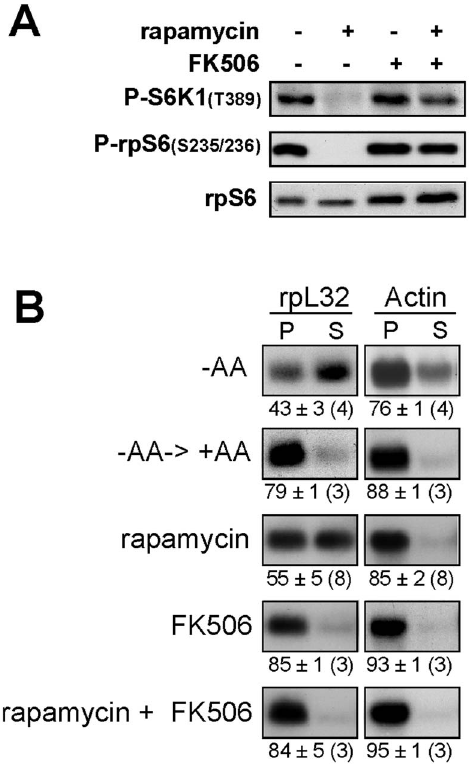
Figure 5. Rapamycin represses the translation of TOP mRNAs in an FKBP-12-dependent fashion. (A) HEK293 cells were amino acid-starved for 3 h and then refed for 3 h in the absence or presence of rapamycin (20 nM), FK506 (20 mM), or both. Cytoplasmic proteins were subjected to Western blot analysis. (B) HEK293 cells were amino acid-starved for 3 h ( 2 AA), refed for 3 h ( 2 AA R + AA) in the absence or presence of rapamycin (20 nM), FK506 (20 mM) or both. Cytoplasmic extracts were subjected to polysomal